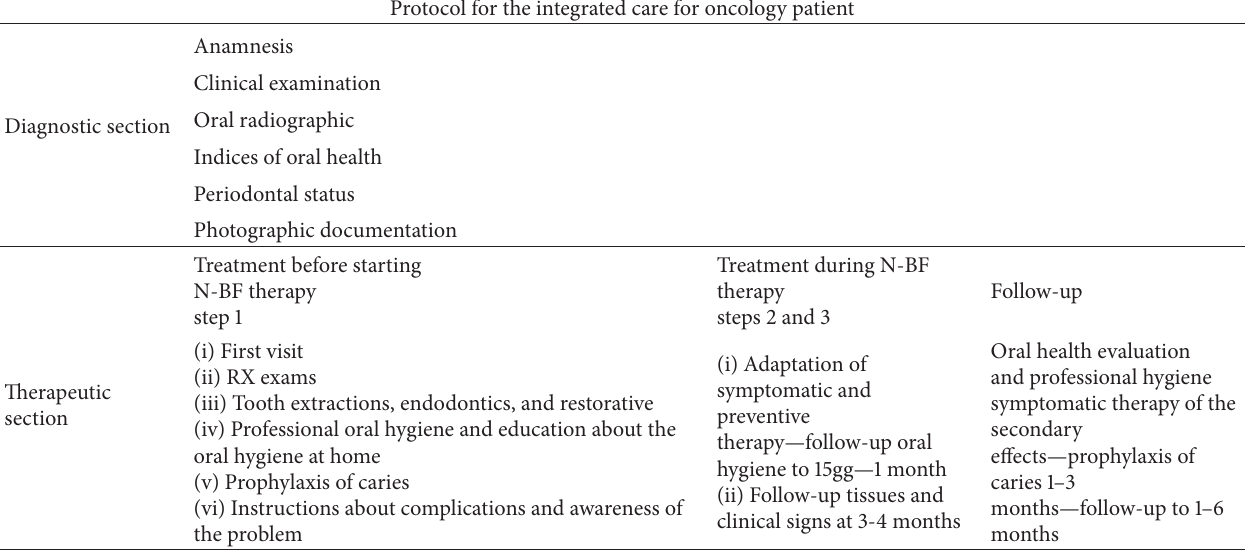
Table 1: Clinical protocol for the integrated care for oncology patient implemented from 2001 in Surgical and Special Stomatology Division— Ospedali Riuniti Hospital of Ancona [12, 13].